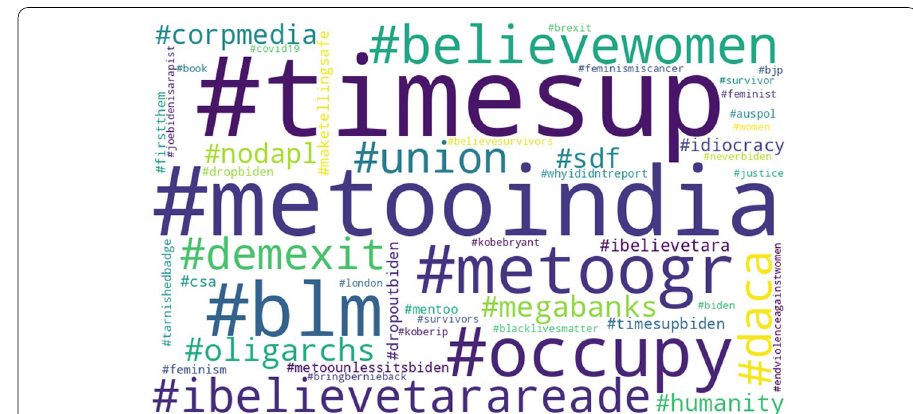
Fig. 5 Top‑50 popular hashtags used by the users labeled as “conservative” in #metoo